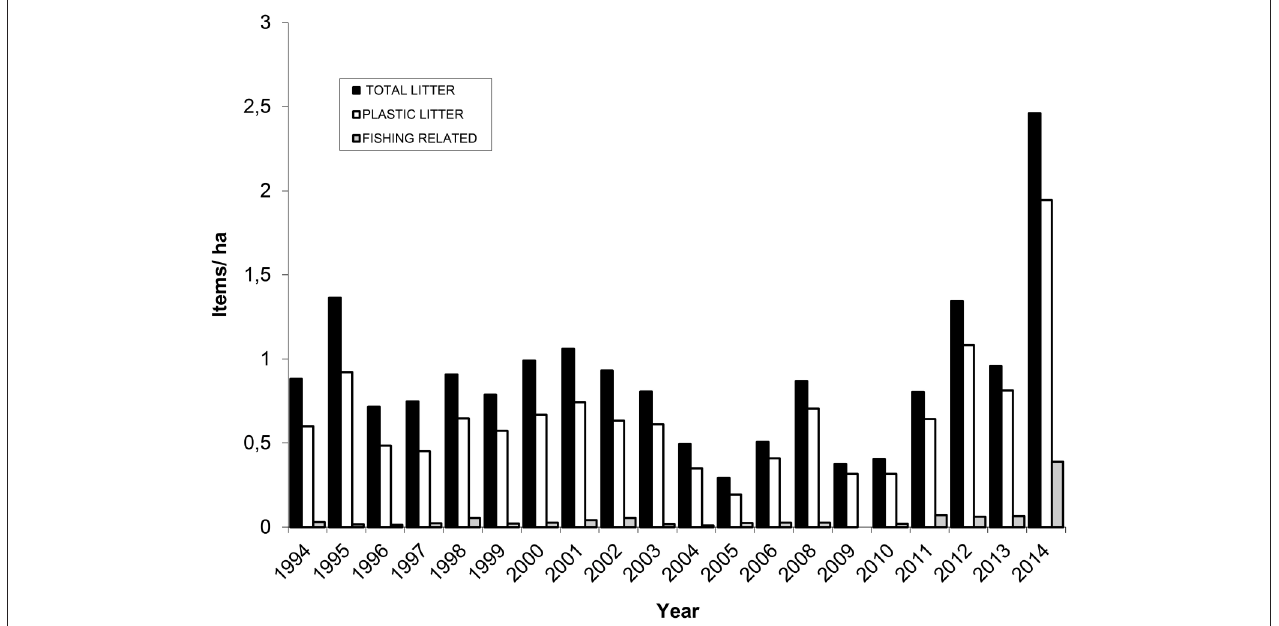
FIGURE 1 | Density of litter collected on the sea floor between 1994 and 2014 in the Gulf of Lion, Mediterranean Sea. Litter (mean values for 70 sites) was collected during the Mediterranean International Bottom Trawl Surveys (MEDITS) dedicated to fish stock assessments, using a stratified sampling scheme (protocol at http://www.sibm.it/SITO%20MEDITS/principaleprogramme.htm) and 20mm mesh. Results are expressed in